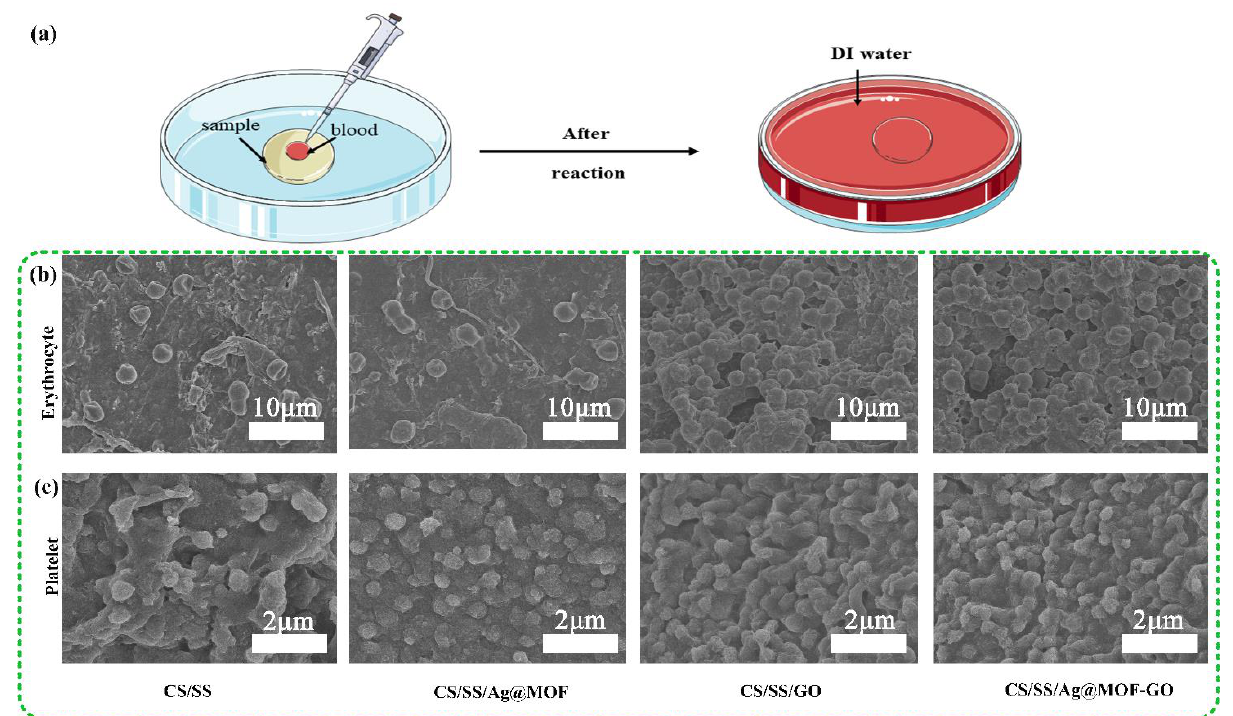
Figure 5. ( a ) Schematic illustration of the in vitro clotting test; SEM images of ( b ) erythrocyte and ( c ) platelet adhesion to the